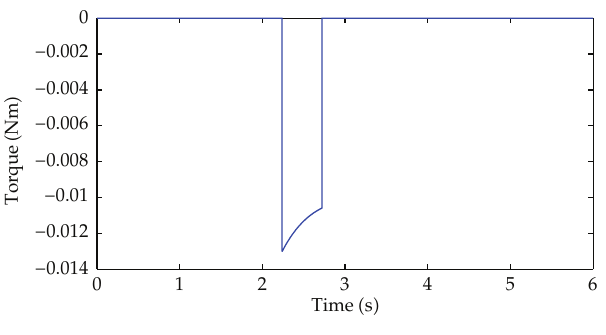
Figure 7: The input control u 3